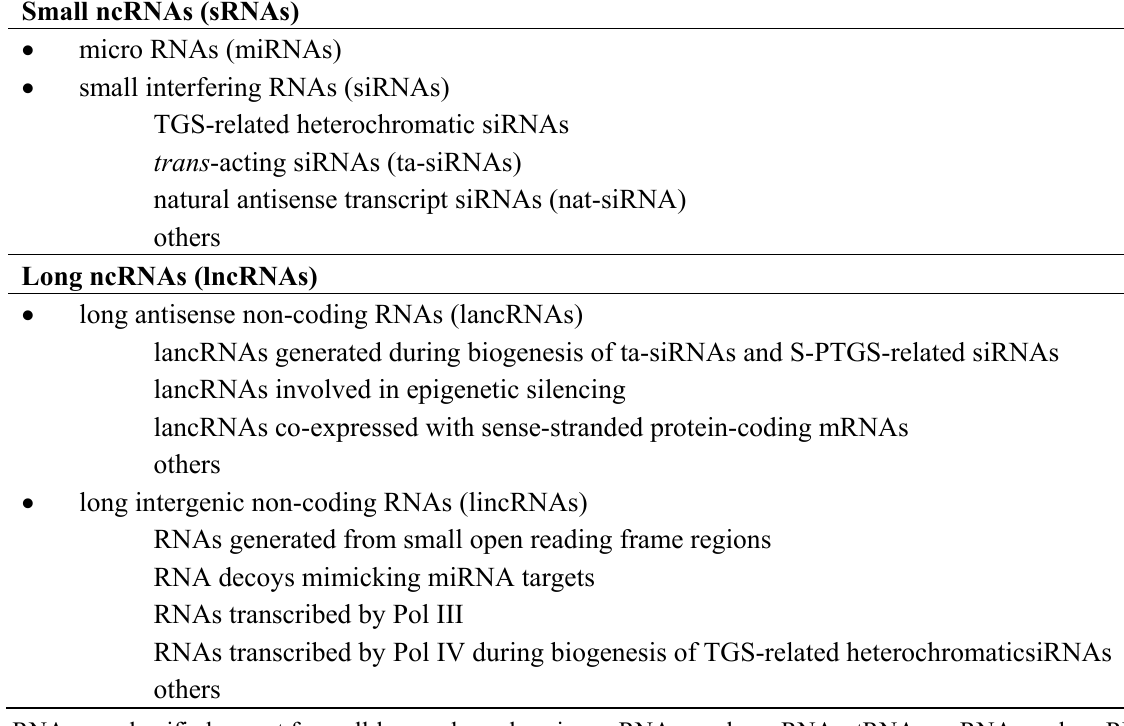
Table 1. Classification of non-coding RNAs (ncRNAs) (1) involved in abiotic stress responses. Small ncRNAs